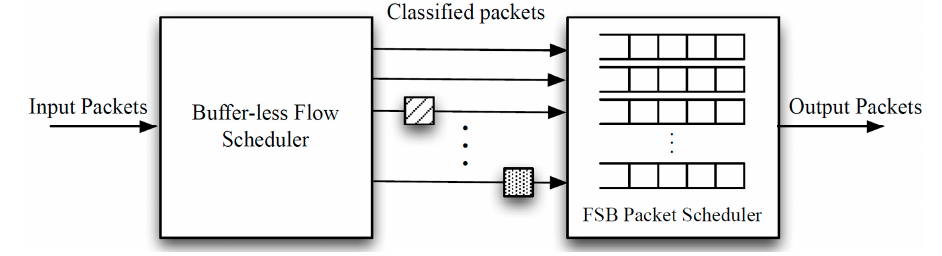
Figure 1. Two-stage packet scheduling architecture.